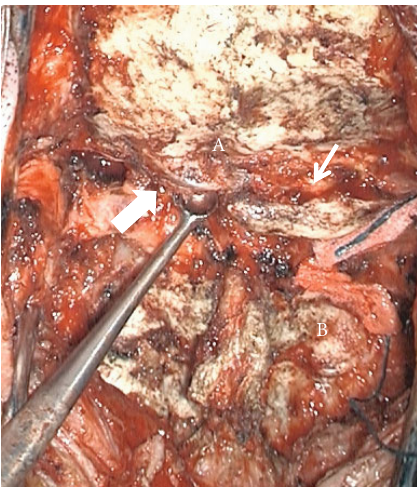
Figure 5: Case 2: intraoperative image. (A) Occiput. (B) C2 vertebra. (Upper arrow) left VA coursing above the free C1 posterior ring. (Thick arrow) right VA fused C1 posterior ring assimilated to the